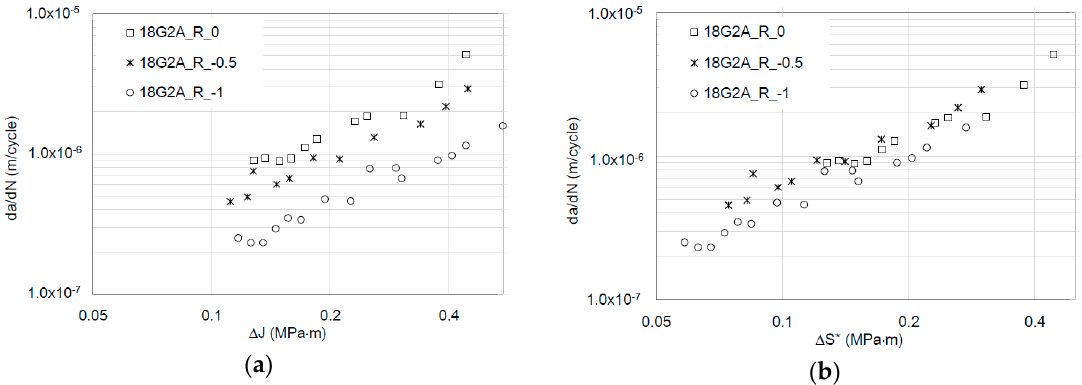
Figure 8. Fatigue crack growth curves for 18G2A steel ( a ) based on the Δ J crack driving force (based on data from [37] and ( b ) based on the new, averaged Δ S* crack driving force.